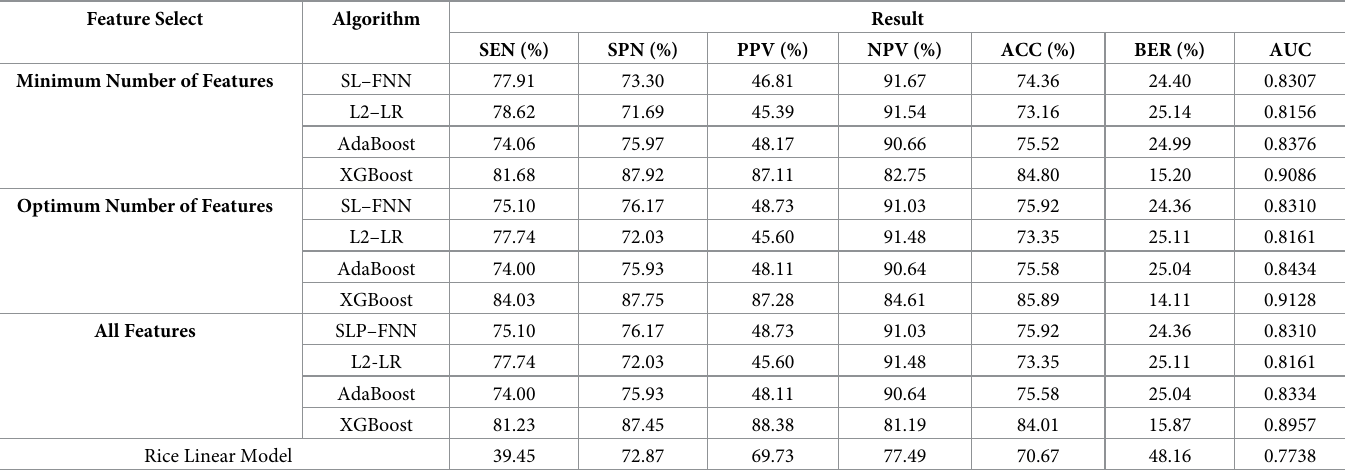
Table 6. Identification results of four algorithms on test sets for different feature